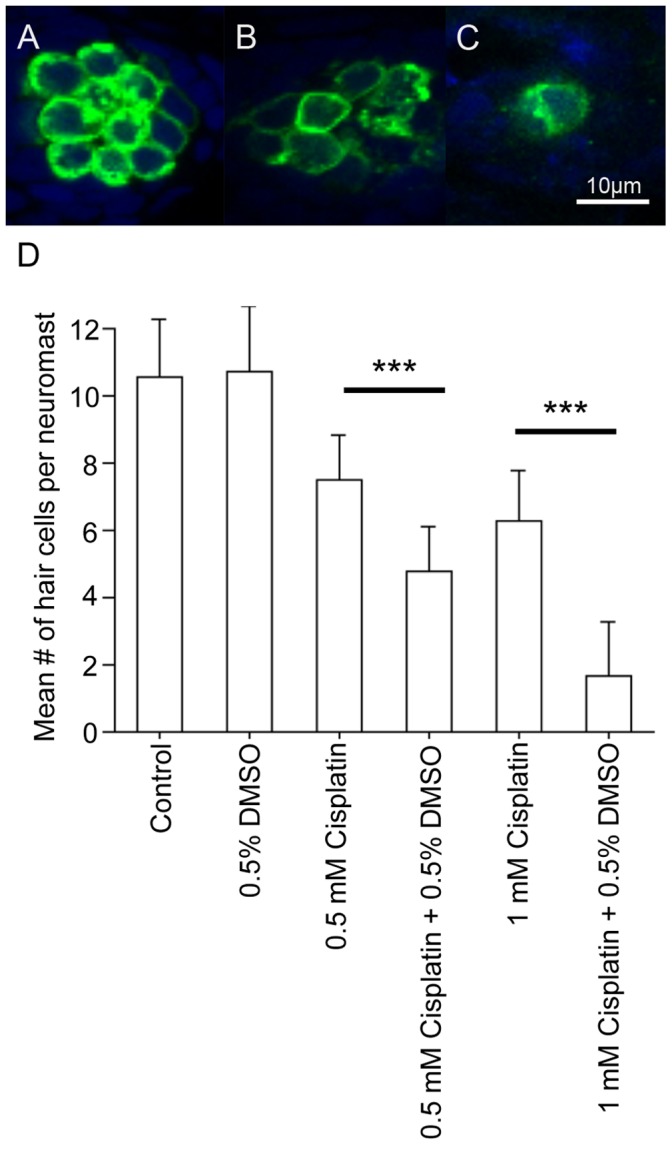
Co-treatment with DMSO and cisplatin compromises hair cell morphology and kills hair cells.Zebrafish were treated with embryo medium (control), 0.5% DMSO, two different concentrations of cisplatin (0.5 mM or 1 mM), or cisplatin (0.5 mM or 1 mM) with 0.5% DMSO. Representative images of (A) control neuromasts, (B) neuromasts exposed to 1 mM cisplatin, and (C) neuromasts exposed to 1 mM cisplatin and 0.5% DMSO. When compared to a control O2 neuromast (A), fewer hair cells were present in the O2 neuromast of a 1 mM cisplatin-treated larva (B). When cisplatin is co-incubated with 0.5% DMSO (C), even fewer hair cells remain within the neuromast. (D) When larvae were treated with 0.5% DMSO in conjunction with cisplatin, there was a significant reduction in the number of hair cells when compared to cisplatin treatment alone indicating a synergistic effect of DMSO and cisplatin. Results are the mean values ± SD. n = 13−51 neuromasts for each treatment group. ***p<0.001.